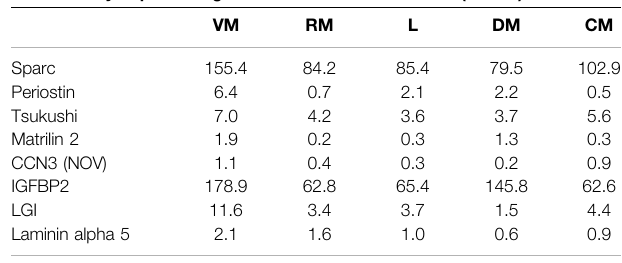
TABLE 1 | List of ECM genes examined in the combinatorial arrays, with expression levels in the RNA sequencing study of Le Manno et al. (2016) shown in reads per kilobase of transcript per million mapped reads (RPKM). As shown,threegroupswereselected – thosemosthighlyexpressedintheVM,those whose expression in the VM changed during development, and those highly expressed throughout development. VM: ventral midbrain; RM: rostral midbrain; L: lateral plates; DM: dorsal midbrain; CM: caudal midbrain. Differentially expressed genes in the ventral midbrain